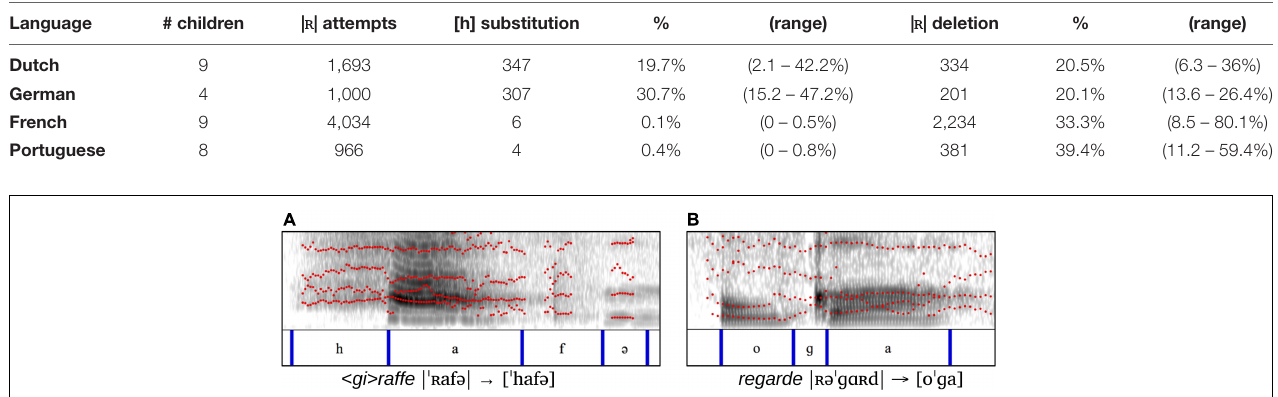
TABLE 1 | General trends in the acquisition of | ö | in singleton onsets across four languages. Language